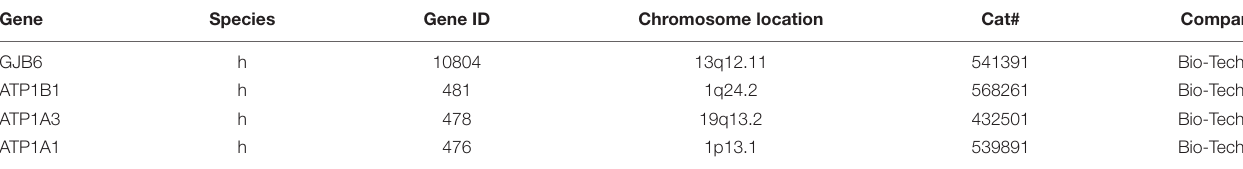
TABLE 1 | The mRNA probes used in the present